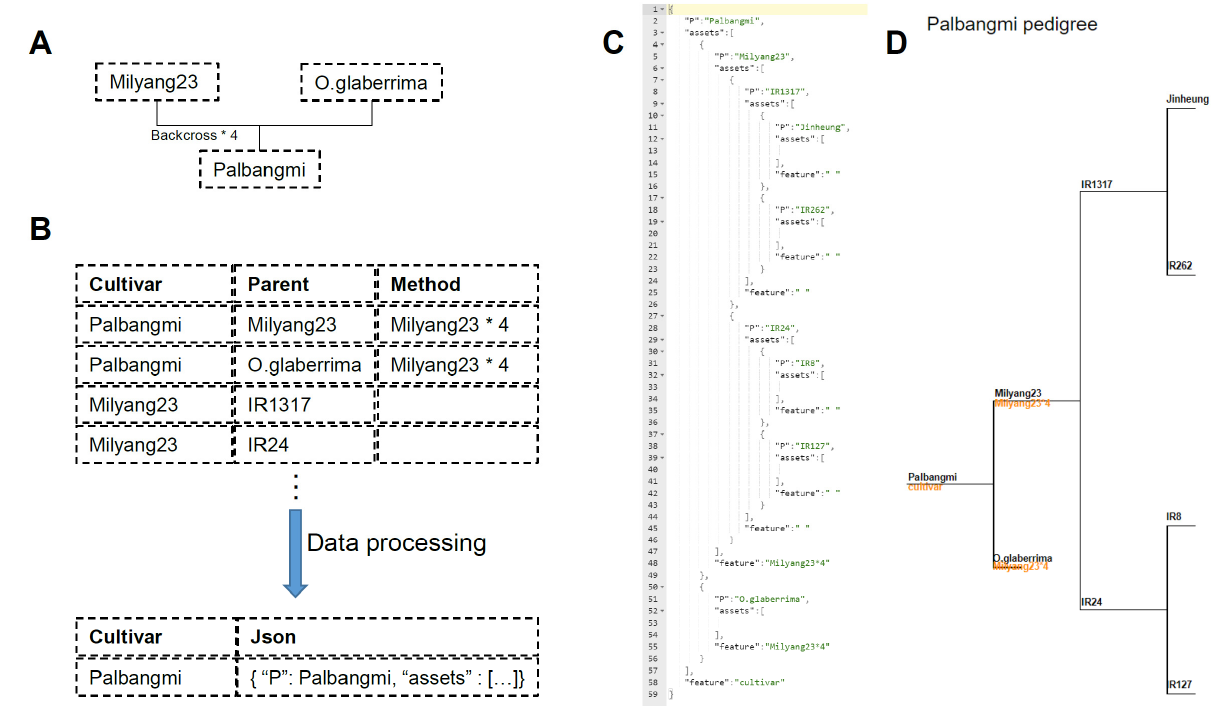
Figure 2. Example of the table coding scheme. ( A ) Parent‑cultivar relationship in the pedigree image. ( B ) The parent‑cultivar relationship is coded into two rows containing maternal and paternal lines. The method column contains the breeding methods, such as the number of backcrosses or mutagen treatments. The table is converted into a parent‑child tree for each cultivar with a data processing function. ( C ) Converted JSON format describing the pedigree of “Palbangmi”. ( D ) Hierarchical tree based on consolidated parent‑cultivar relationships of “Palbangmi”. The breeding method informa‑ tion is annotated with orange